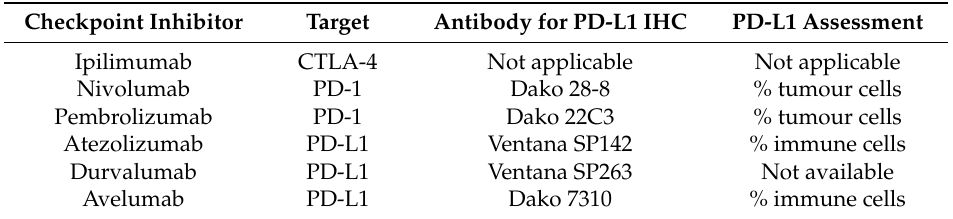
Table 1. Checkpoint inhibitors and corresponding IHC antibodies used in clinical trials for renal cell carcinoma. Checkpoint Inhibitor Target Antibody for PD-L1 IHC PD-L1 Assessment Ipilimumab CTLA-4 Not applicable Not applicable Nivolumab PD-1 Dako 28-8 % tumour cells Pembrolizumab PD-1 Dako 22C3 % tumour cells Atezolizumab PD-L1 Ventana SP142 % immune cells Durvalumab PD-L1 Ventana SP263 Not available Avelumab PD-L1 Dako 7310 % immune